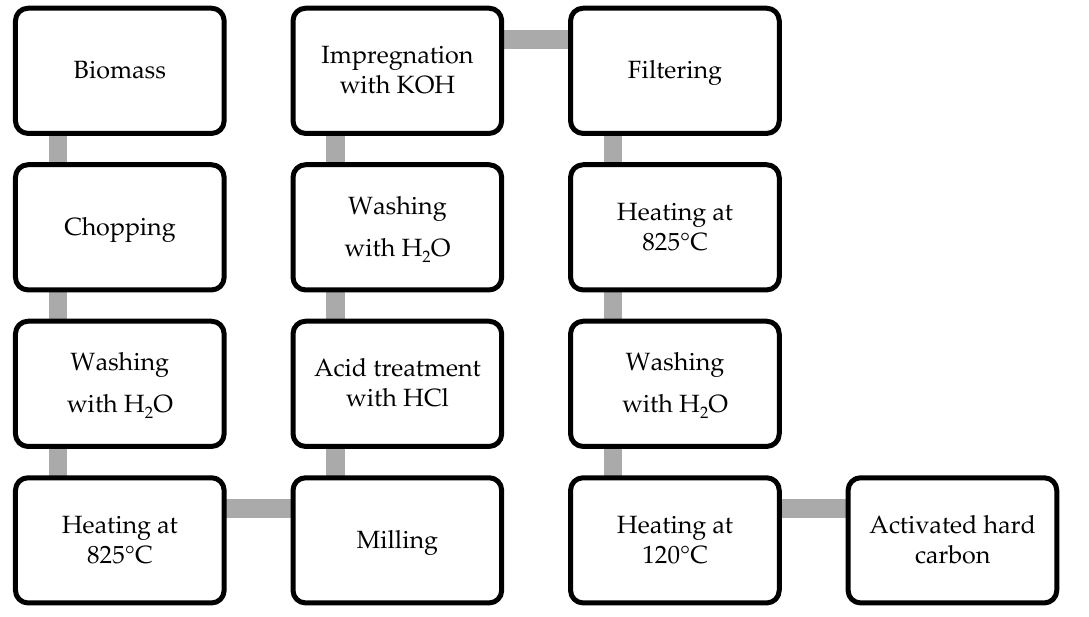
Figure 1. Schematic diagram illustrating the different phases of the production process of the activated hard carbon starting from biomass.